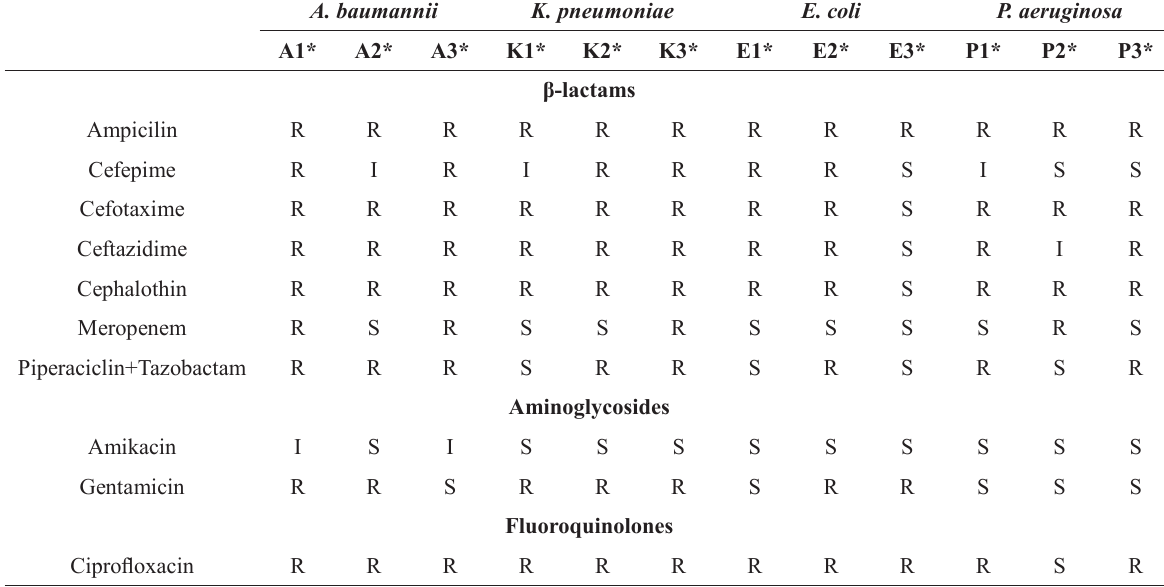
Resistance profile of clinical isolates Acinetobacter baumannii , Klebsiella pneumoniae , Escherichia coli and Pseudomonas aeruginosa against three antibiotic classes used in medical clinic.